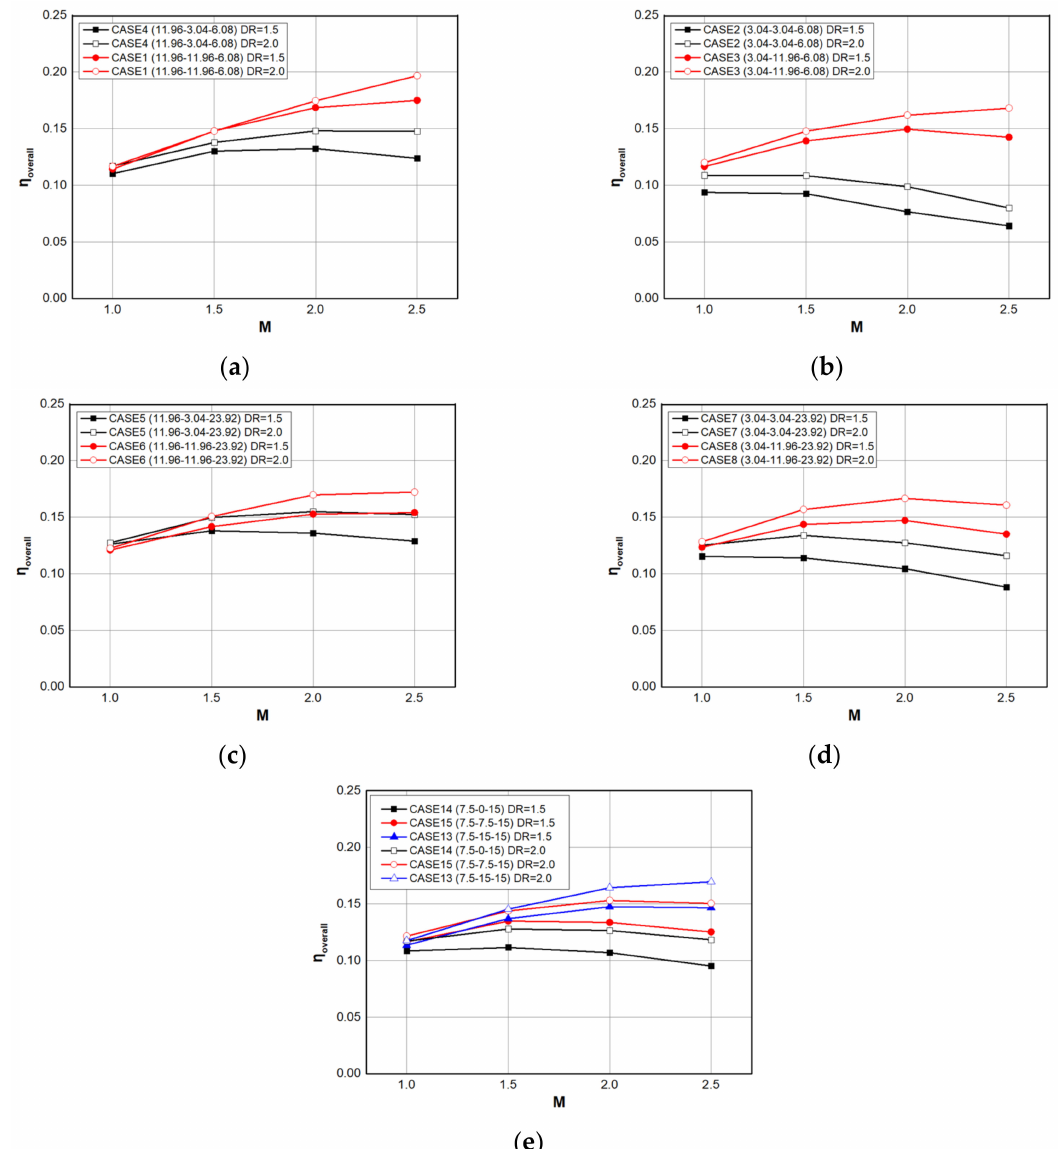
Figure 8. Overall averaged FCE for the effect of leeward lateral expansion angle: ( a ) 11.96- γ lw -6.08 cases; ( b ) 3.04- γ lw -6.08 cases; ( c ) 11.96- γ lw -23.92 cases; ( d ) 3.04- γ lw -23.92 cases; ( e ) 7.5- γ lw -15